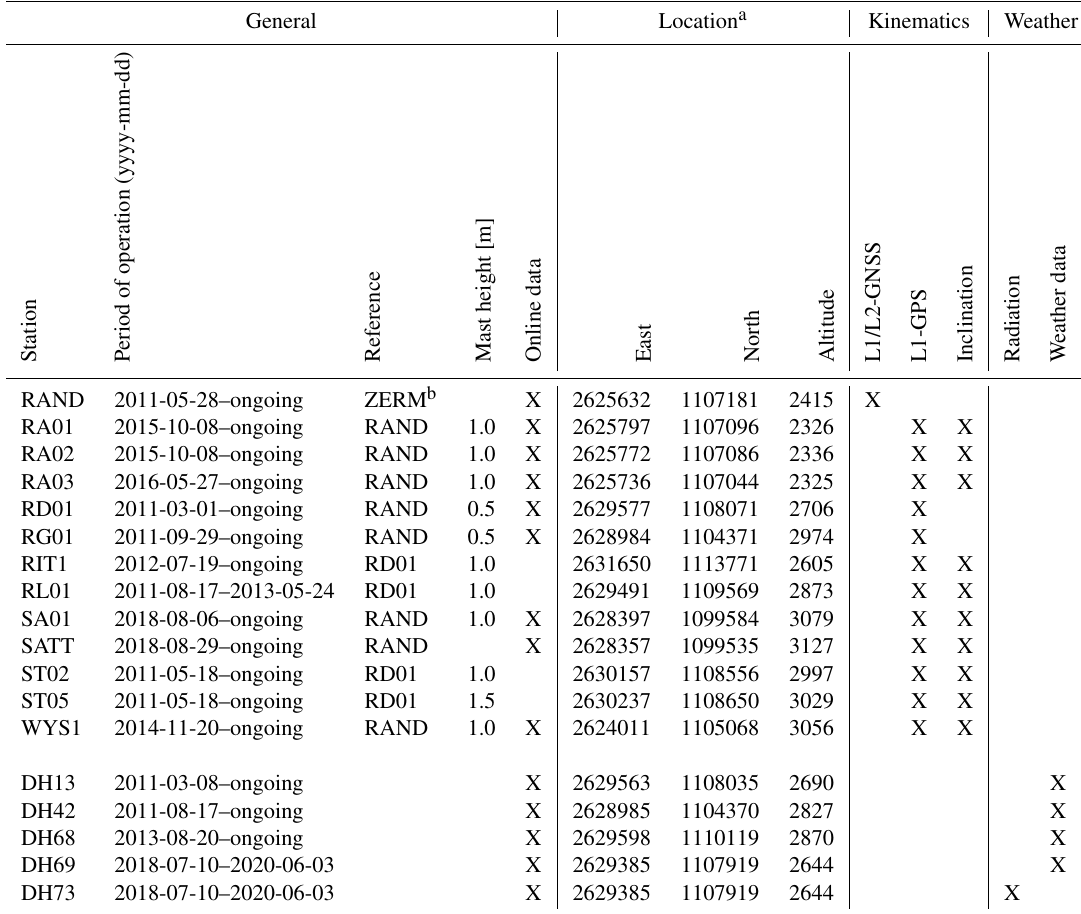
Table A2. Per position overview of the sensors in the Matter Valley field site (see Fig. 2): Part 2. General Location a Kinematics